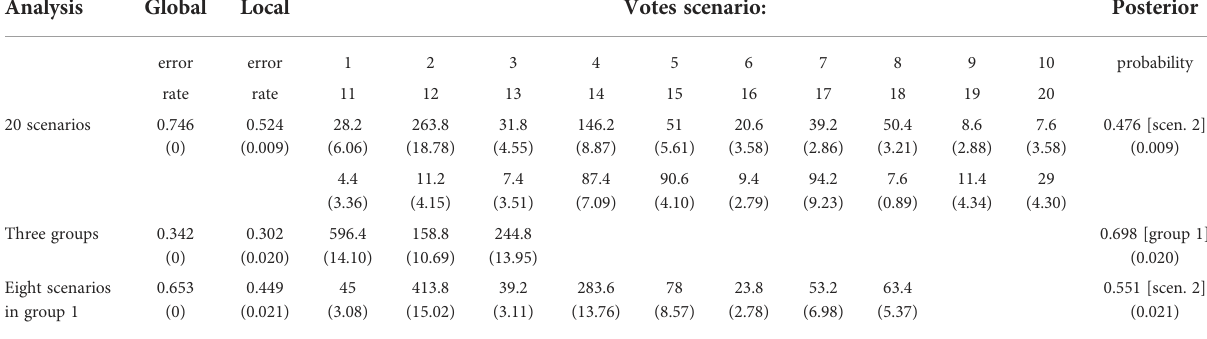
TABLE 1 Results of scenario choice in three DIYABC-RF